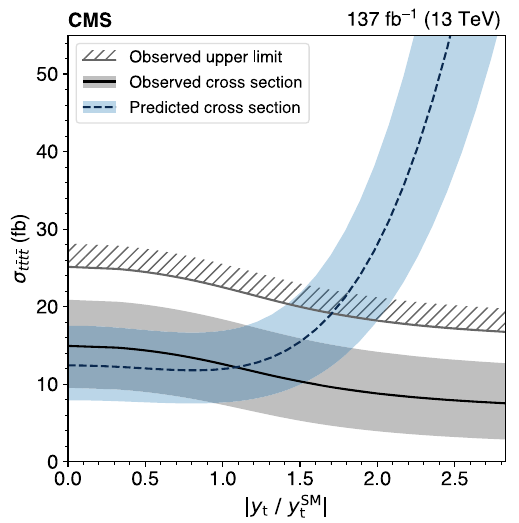
Fig. 6 The 95% CL exclusion regions in the plane of the φ/ Z (cid:8) -top quark coupling versus m φ or m Z (cid:8) . The excluded regions are above the hatched lines